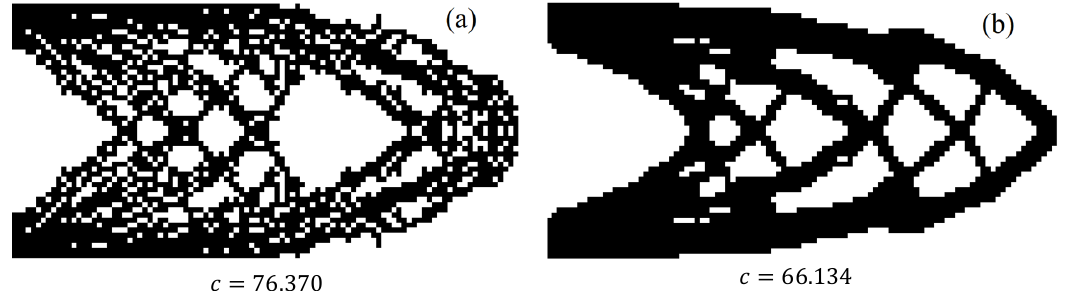
Figure 2. ( a ) Scattered void elements and one edge elements issues (iteration 1000). ( b ) Topology design after using the proposed filtering algorithm (iteration 1000).